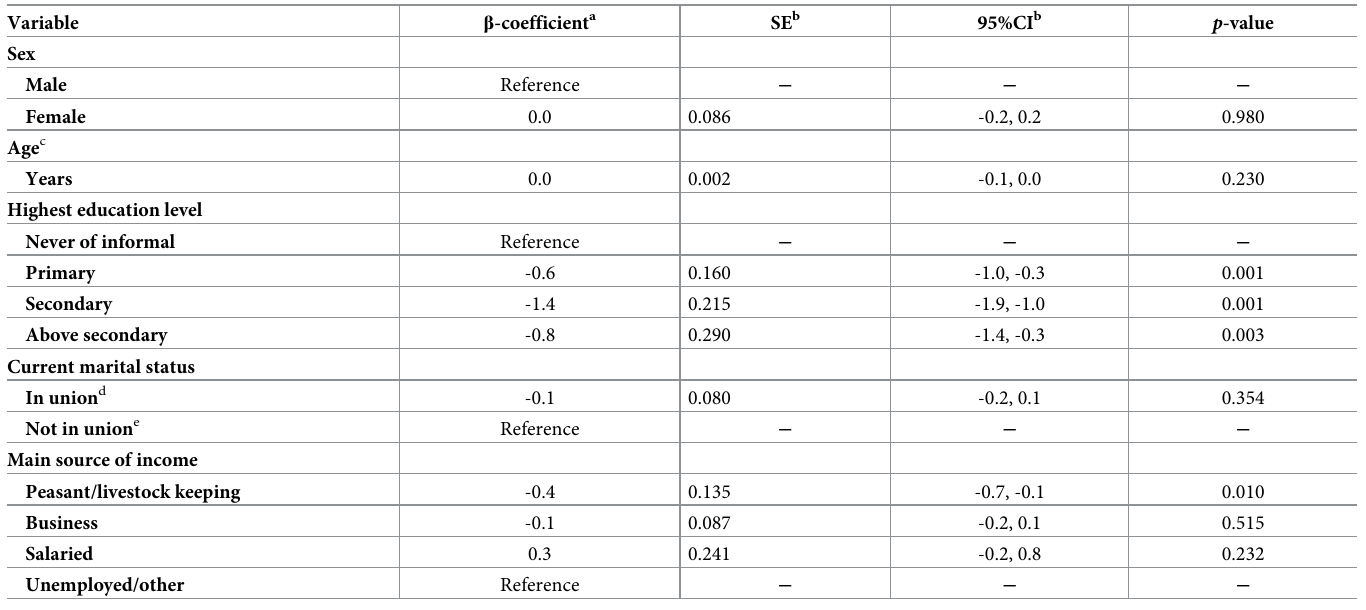
Table 5. Association between individual-level factors and practices towards TB infection